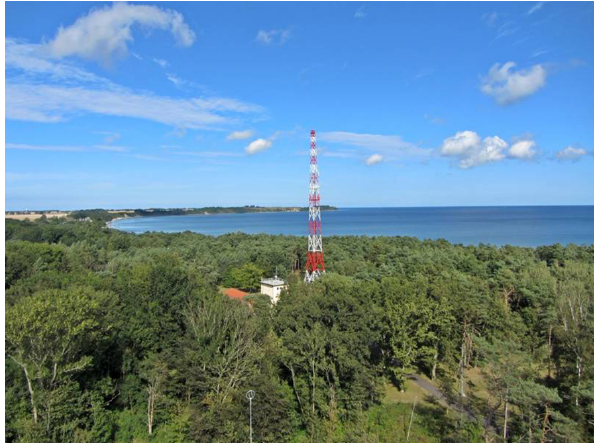
Figure 48. Juliusruh Station